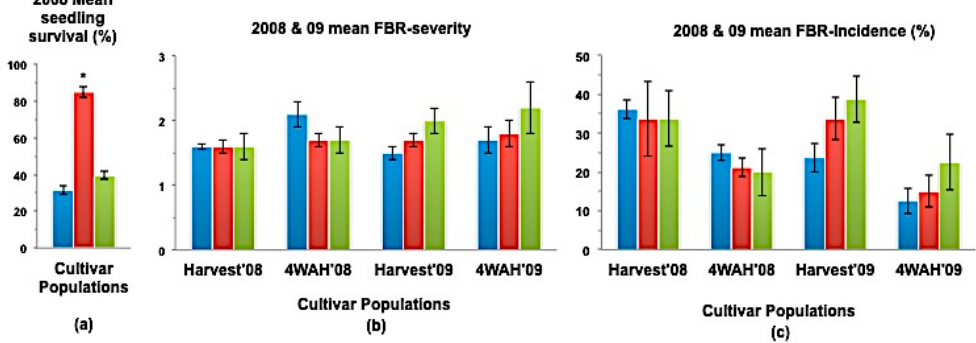
Figure 3. ( a ) Mean seedling survival, ( b ) Mean bulb FBR severity, and ( c ) Mean bulb FBR incidence (%) of NuMex Crispy Ori, SS, and MBS populations in 2008 and 2009 evaluations. Std. error is shown on top of each bar. Grouping legend is provided in Figure 2. (*) Significantly different from original at P = 0.05.